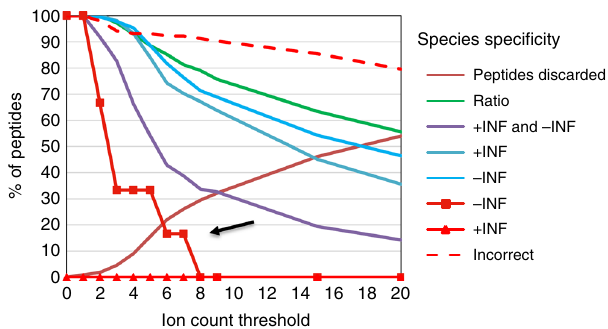
Fig. 4 The number of quanti fi ed peptides decreases with increased ion count threshold per peptide node. The graph shows the percentage of peptides retained in dependence of a minimum number of ion counts per peptide node. The relative number of species-speci fi c peptides that are quanti fi ed as expected, possible, or incorrect, dropped with increasing threshold for the number of ions identi fi ed. Note that the relative number of peptides with incorrect quanti fi cations (e.g., D . virilis , + ∞ and D . melanogaster , − ∞ ) dropped more sharply than peptides measured with expected ratios. The black arrow points to a peptide which is not in